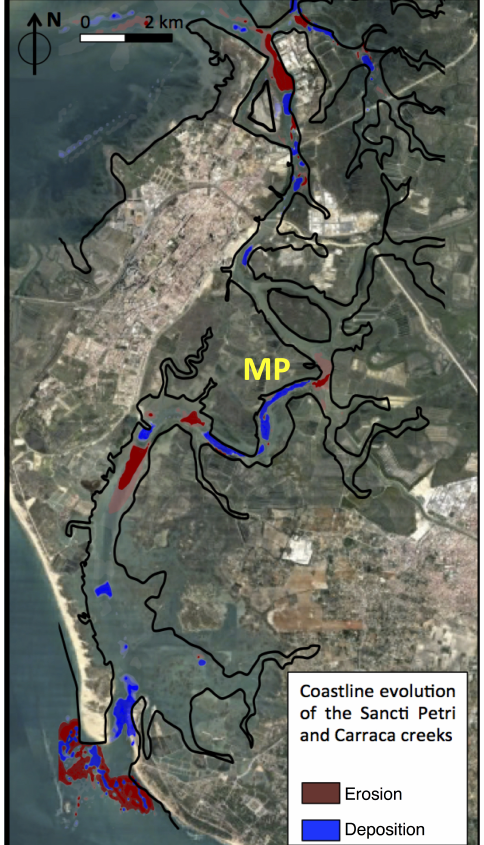
Figure 11. Net evolution of the bottom elevation (mm) computed by the bed evolution model at the end of the